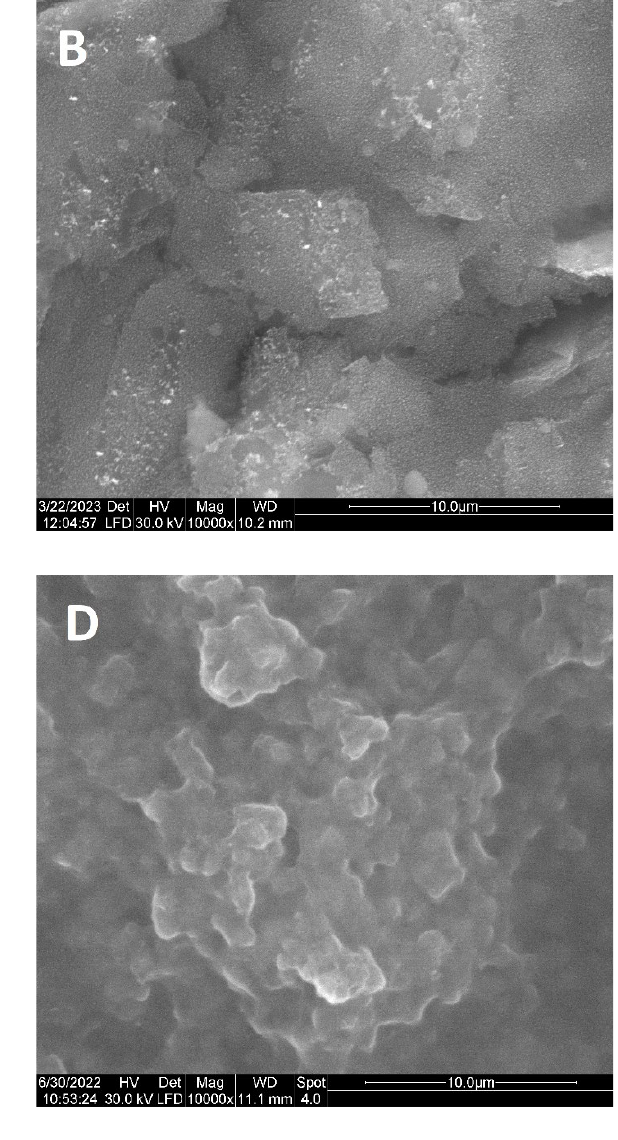
Figure 1. SEM images of: ( A ) SPE, ( B ) CS/SPE, ( C ) MWCNT/SPE, and ( D ) MWCNT-CS/SPE.